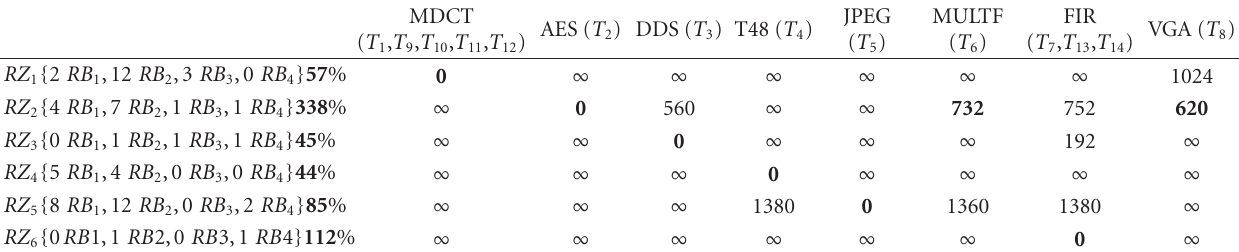
Table 3: The results obtained for Step 1 and Step 2 of Level